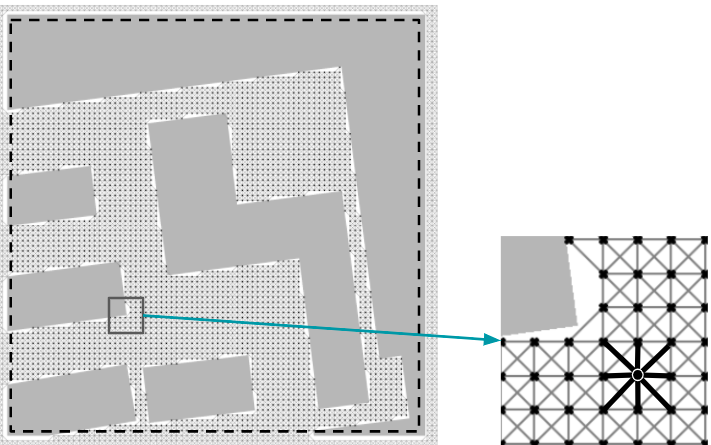
Figure 6. An example of the graph for capturing environment information on the map. The nodes in the graph are one meter apart and directly connected to their neighbor nodes via edges. The figure on the right zooms in on the graph. The highlighted lines illustrate the eight edges that connect a node with all of its neighbor nodes. The dashed line in the left figure indicates the coverage region. Each node within the coverage region is associated with a generated location mentioned in Section